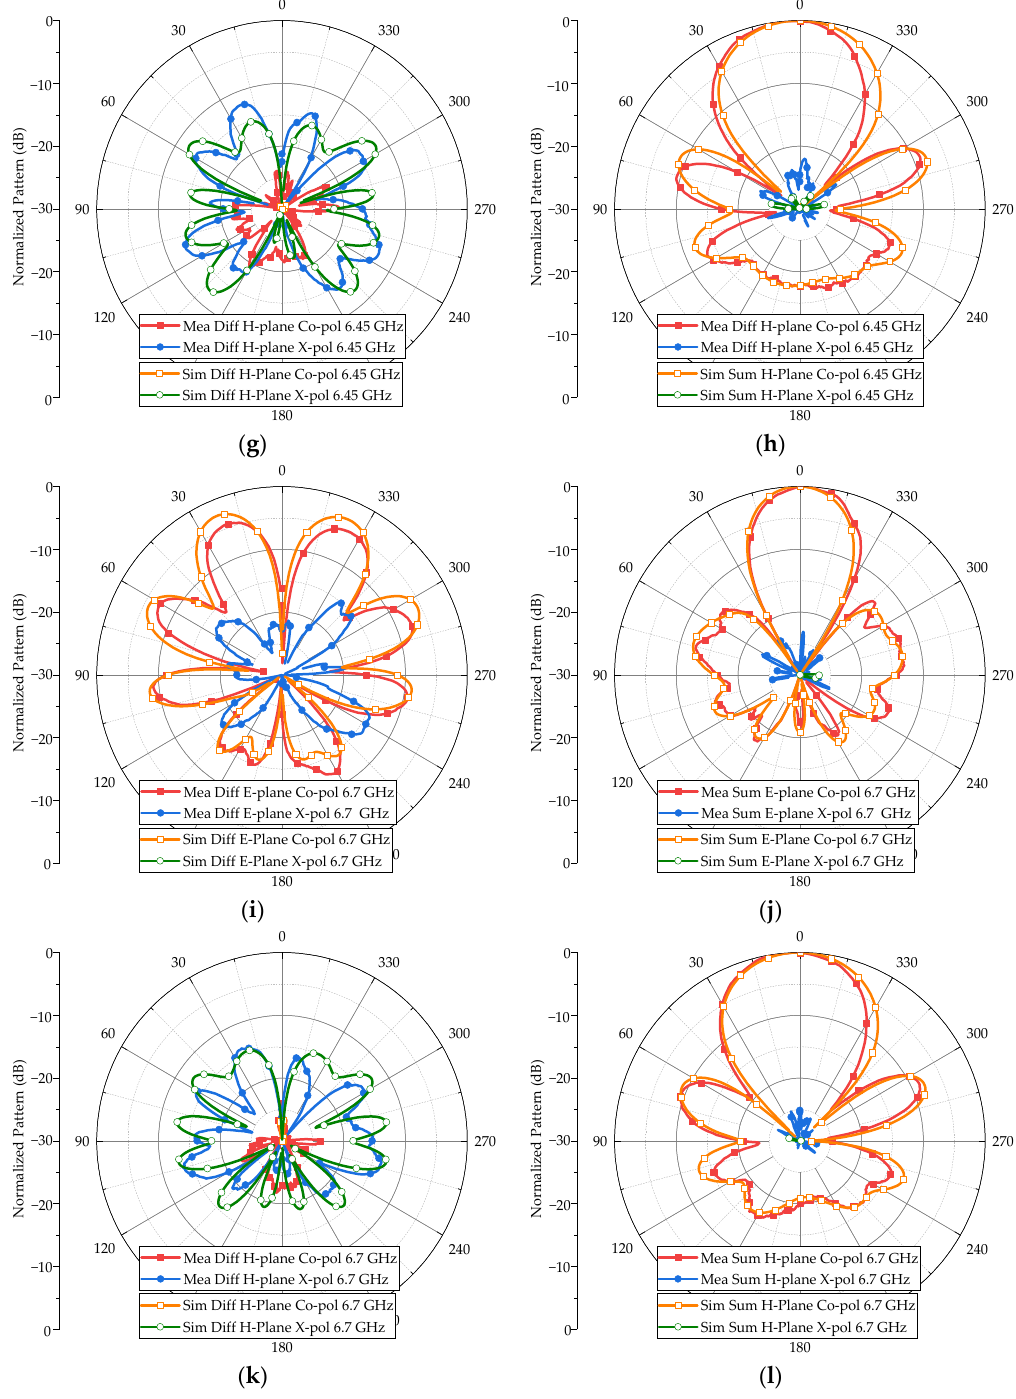
Figure 13. Simulated and measured normalized radiation patterns of co-polarization and cross-polarization. ( a ) E-plane pattern for the difference beam at 5.4 GHz, ( b ) E-plane pattern for the sum beam at 5.4 GHz, ( c ) H-plane pattern for the difference beam at 5.4 GHz, ( d ) H-plane pattern for the sum beam at 5.4 GHz, ( e ) E-plane pattern for the difference beam at 6.45 GHz, ( f ) E-plane pattern for the sum beam at 6.45 GHz, ( g ) H-plane pattern for the difference beam at 6.45 GHz, ( h ) H-plane pattern for the sum beam at 6.45 GHz, ( i ) E-plane pattern for the difference beam at 6.7 GHz, ( j ) E-plane pattern for the sum beam at 6.7 GHz, ( k ) H-plane pattern for the difference beam at 6.7 GHz, ( l ) H-plane pattern for the sum beam at 6.7 GHz.